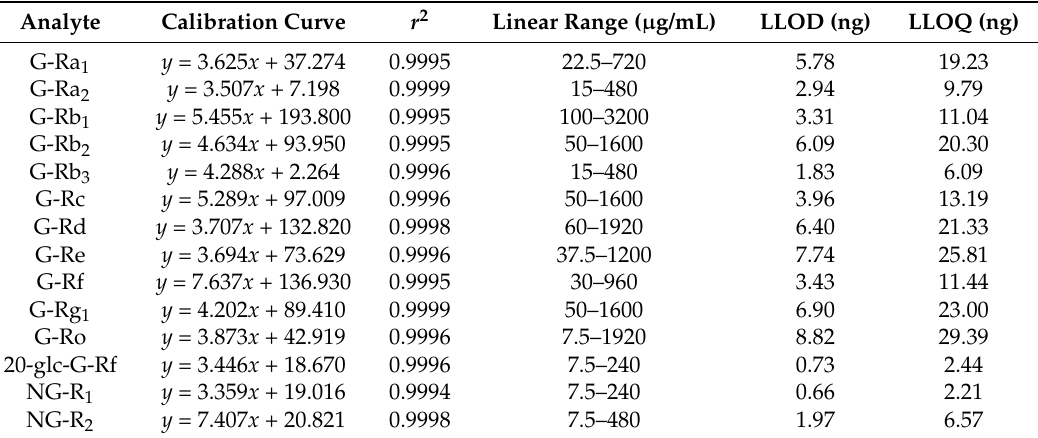
Table 1. Linear calibration curves of 14 ginsenosides.